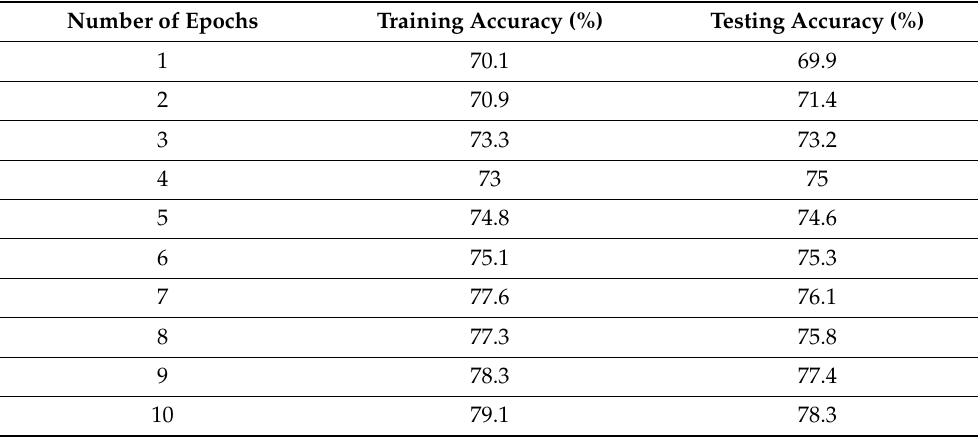
Table 3. Accuracy results of 10 learning epochs for the advanced learning